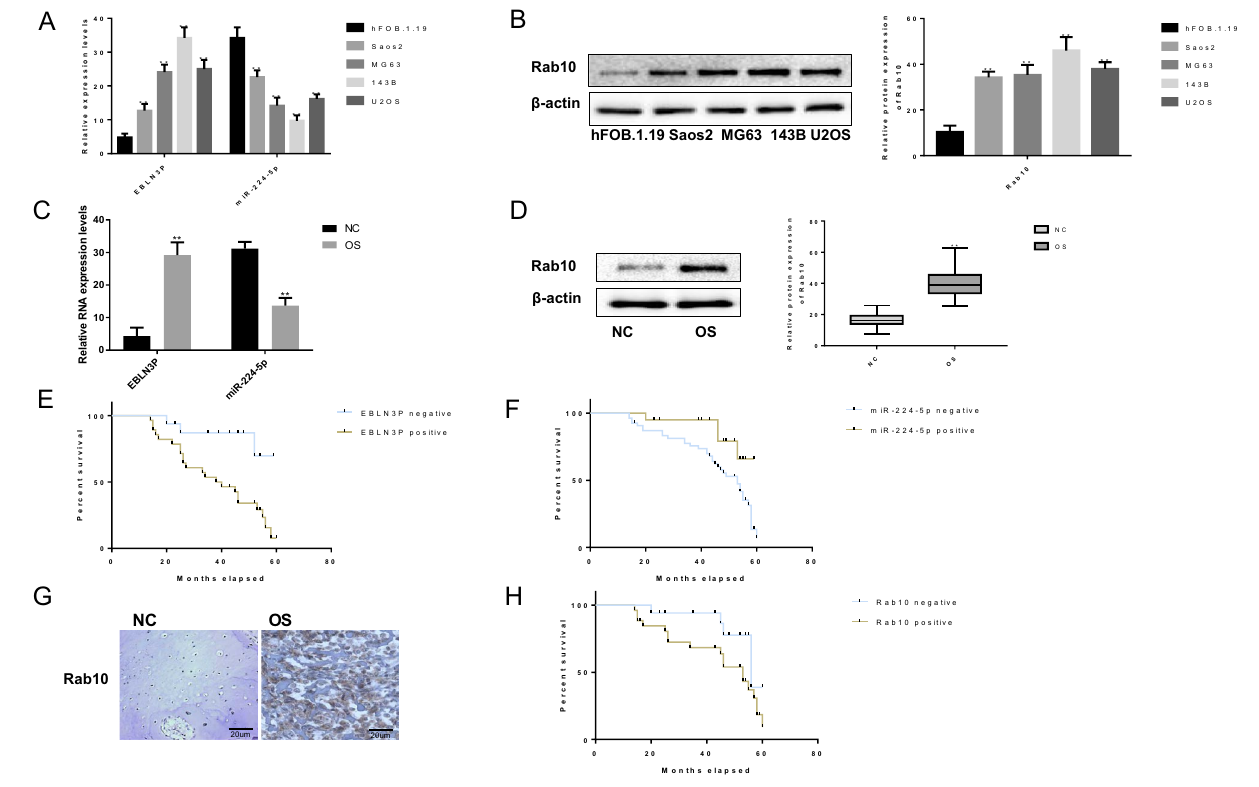
Figure 1. EBLN3P and Rab10 were upregulated while miR-224-5p was downregulated in osteosarcoma tissues and cell lines. ( A ) The expression levels of EBLN3P and miR-224-5p were assessed in osteosarcoma cell lines (Saos2, 143B, MG63, and U2OS) and the normal human fetal osteoblast cell line (hFOB.1.19) by RT-qPCR. ( B ) The western blotting results revealed that Rab10 was expressed at a higher level in the four osteosarcoma cell lines compared with the hFOB.1.19 cell line. ( C ) The expression patterns of EBLN3P and miR-224-5p were examined in osteosarcoma samples (OS) and non-cancerous tissues (NC) via RT-qPCR. ( D ) The expression patterns of Rab10 were examined in osteosarcoma samples (OS) and non-cancerous tissues (NC) via western blotting. ( E ) The associations between EBLN3P expression and the prognosis of patients with osteosarcoma were investigated. ( F ) Associations between miR-224-5p expression and the prognosis of patients with osteosarcoma. ( G ). The expression patterns of Rab10 were examined in osteosarcoma samples (OS) and non-cancerous tissues (NC) via IHC. ( H ) Associations between Rab10 expression and the prognosis of patients with osteosarcoma. EBLN3P endogenous bornavirus-like nucleoprotein, OS osteosarcoma samples, NC non-cancerous tissues, Rab10 Ras-related protein 10, RT-qPCR reverse transcription-quantitative PCR, IHC